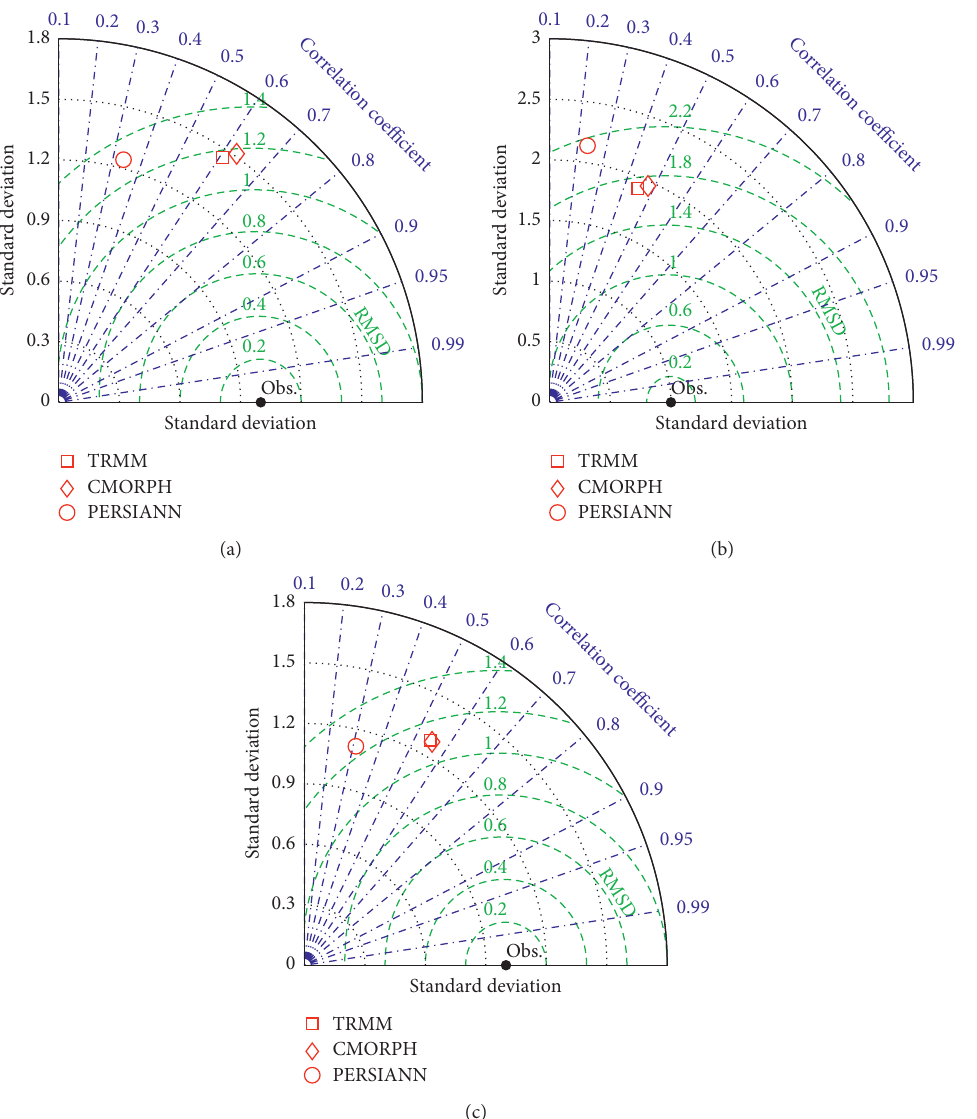
Figure 11: Taylor diagrams for the satellite estimates of (a) light rainfall, (b) moderate rainfall, and (c) heavy rainfall and above derived from the area-average daily